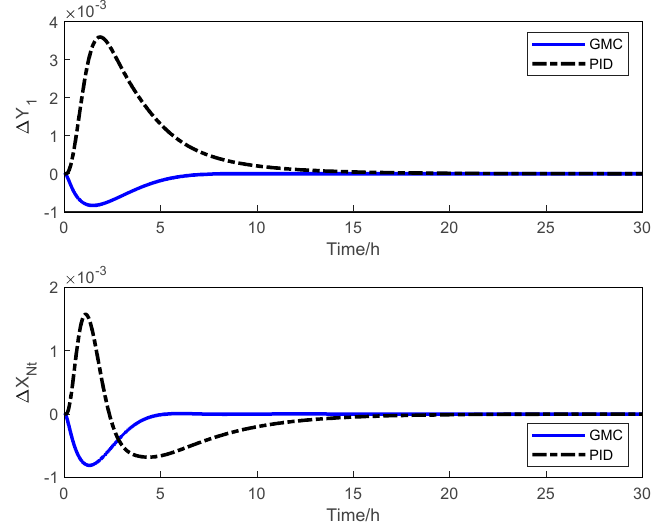
Figure 14. Response curve of controlled variable when the feed composition Z f +20% in Case 1. Table 4. Error index of GMC in Case 1.